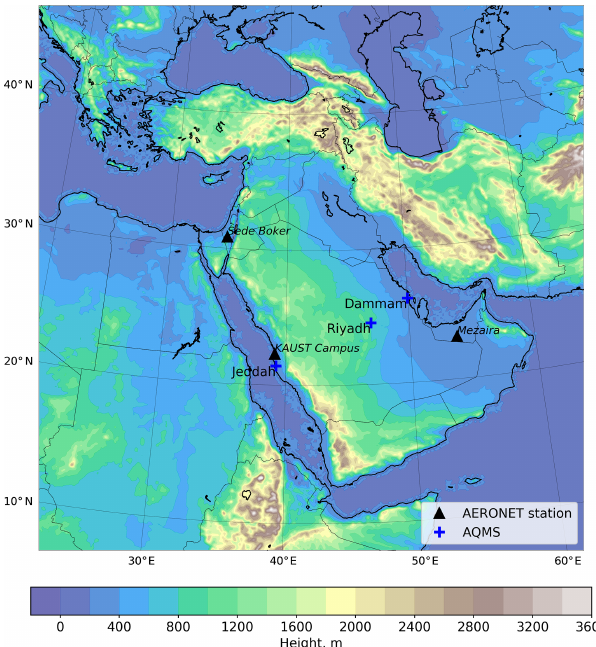
Figure 1. Simulation domain with marked locations of the air qual- ity monitoring stations (AQMSs) and Aerosol Robotic Network (AERONET)